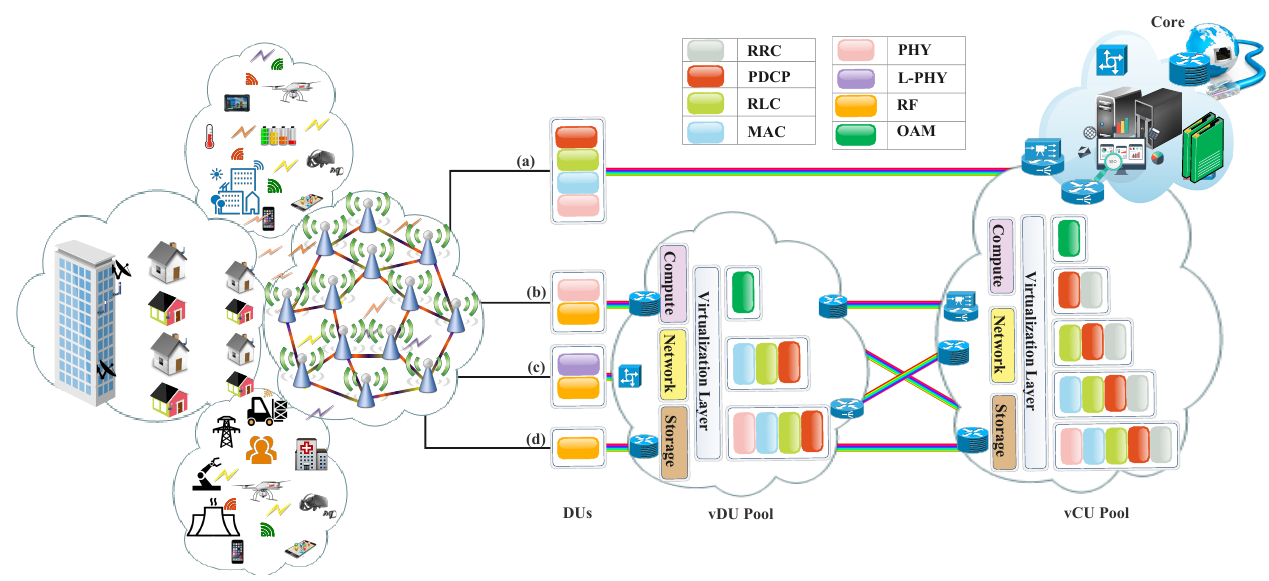
Figure 30. vRAN with PTNI for different use cases ( a ) mode A, ( b ) mode B, ( c ) mode C, and ( d ) mode